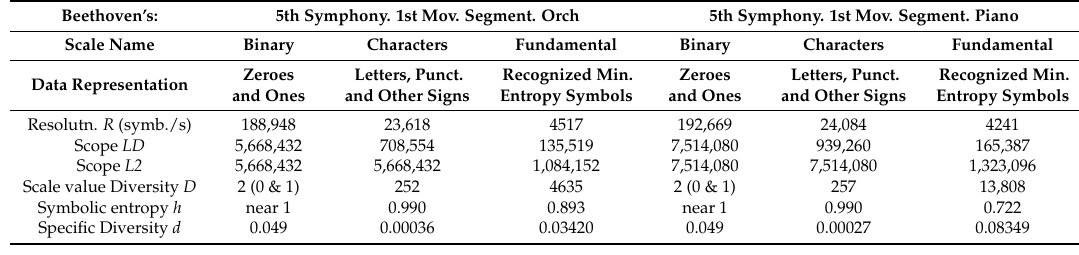
Table 5. Effects of different observation scales over the quantity of information of a segment of Beethoven’s 5th Symphony versioned by a full orchestra and piano solo.